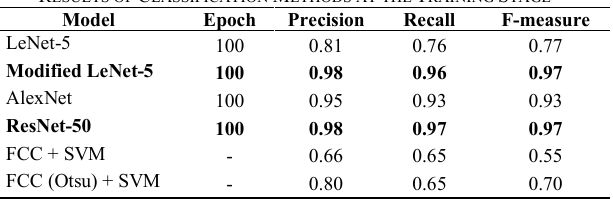
Fig. 10. Comparison of the classification methods in the training stage TABLE 1 R ESULTS OF C LASSIFICATION M ETHODS AT THE T RAINING S